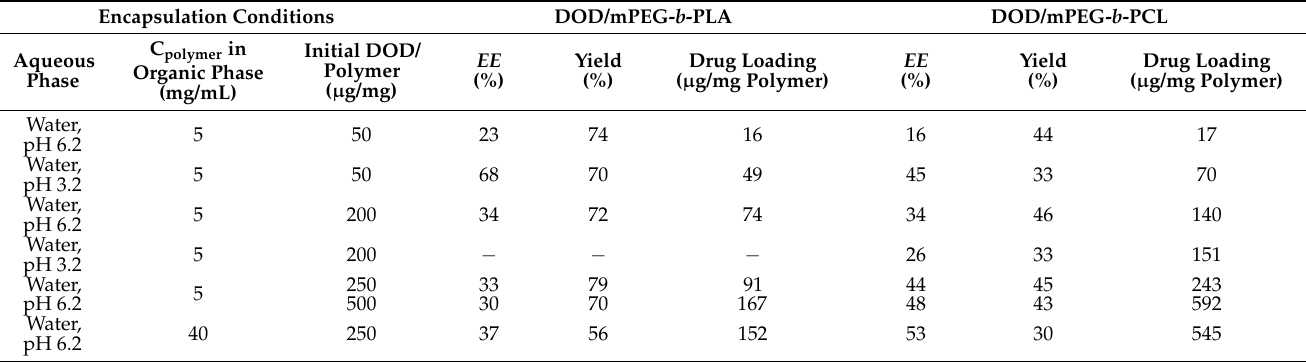
Table 3. Comparison of the results for DOD encapsulation depending on the loading